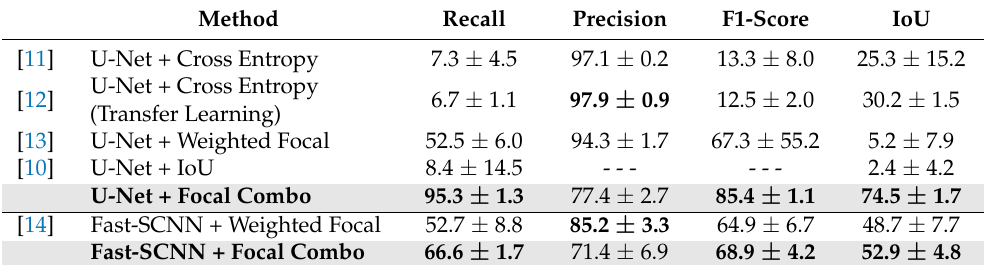
Table 8. Results in comparison to existing methods in (%) for the road marking